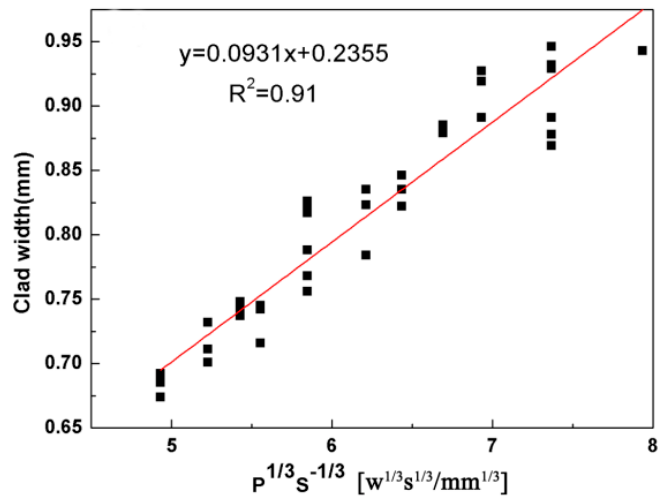
Figure 4. Relationship between the clad width and P 1/3 S –1/3 .